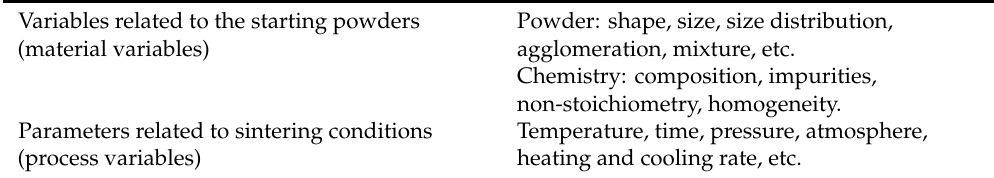
Table 1. Variables a ff ecting sinterability and